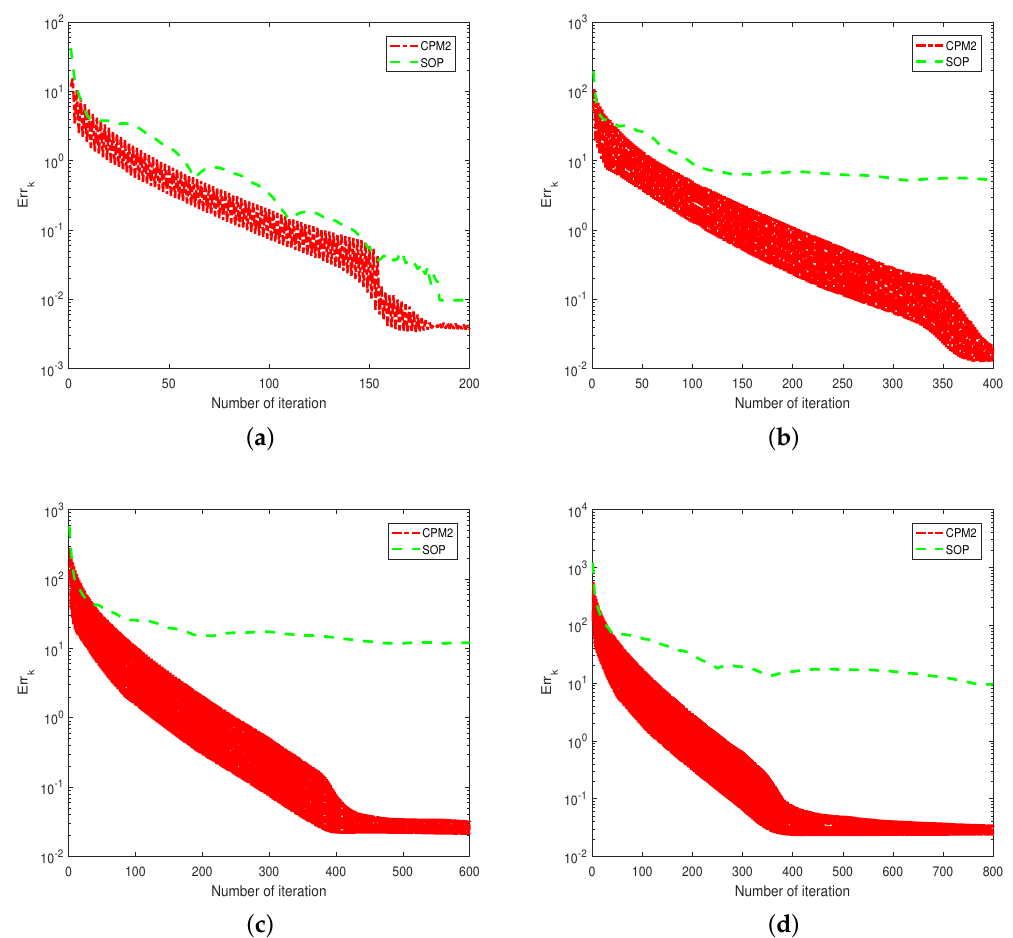
Figure 3. ( a ) ( m , n ) = (20, 40); ( b ) ( m , n ) = (200, 400); ( c ) ( m , n ) = (500, 1000); ( d ) ( m , n ) = (1000, 2000). Comparison of the CPM1 and SOP for different m and n of Example 2.